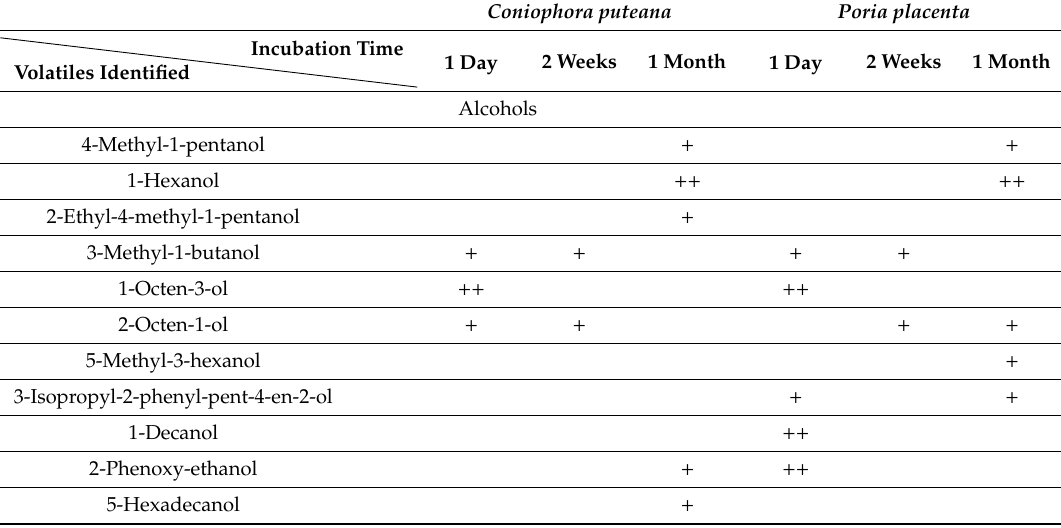
Table 1. Overview showing the range of MVOC levels emitted by Coniophora puteana and Poria placenta after one day, two weeks and one month of incubation. Coniophora puteana Poria placenta Incubation Time